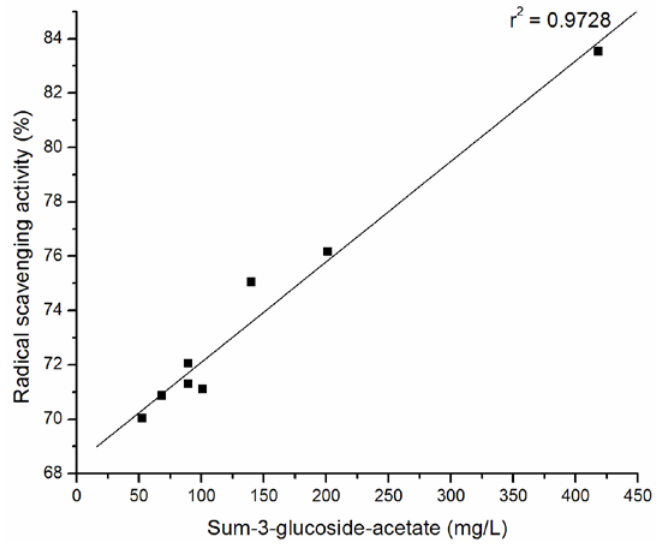
Figure 4. Relationship between radical scavenging activity and sum of glucoside-acetates of selected Cabernet Sauvignon wine samples.